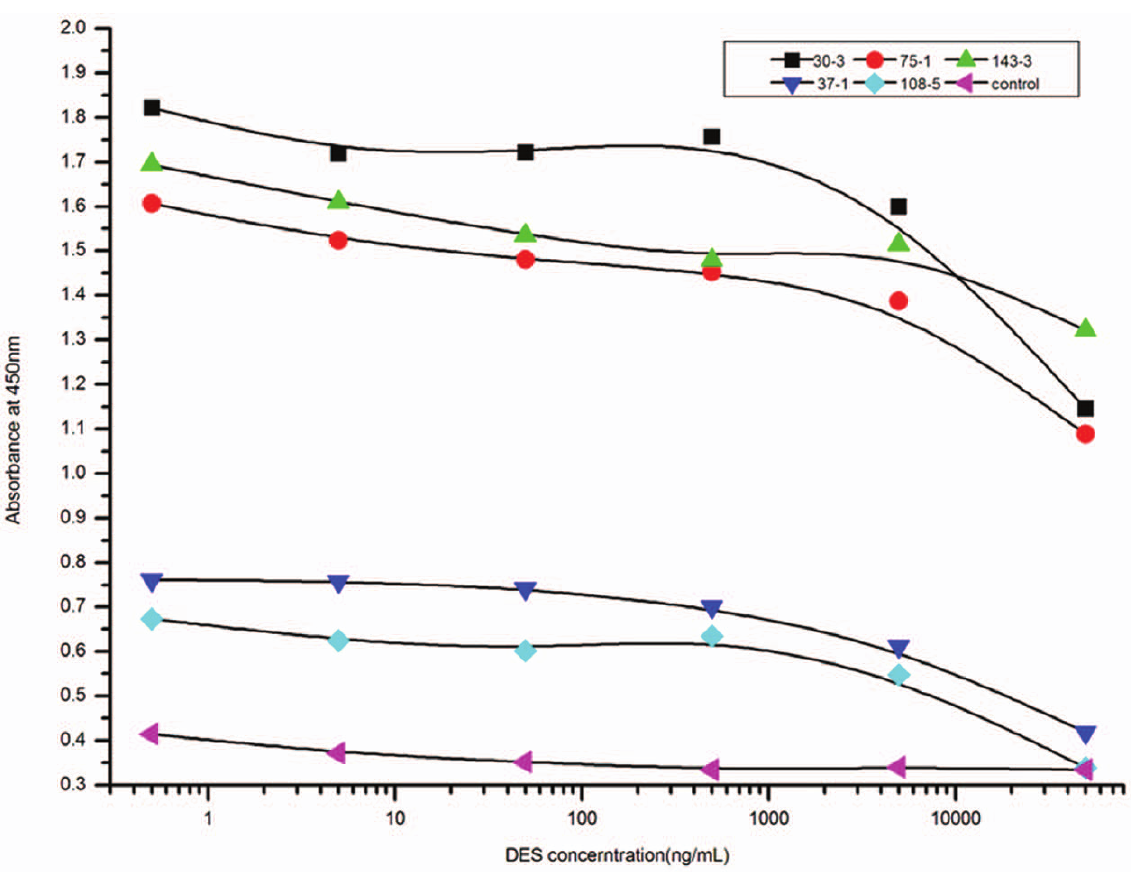
Figure 6. Competition assay for scFv to DES. Different concentrations of free DES, ranging from 0.0005 to 50 m g/mL were used to inhibit the binding of the scFvs to DES-OVA conjugate. Control was the supernatant of E. coli the BL21 (DE3) with pTIG-TRX without scFv gene.